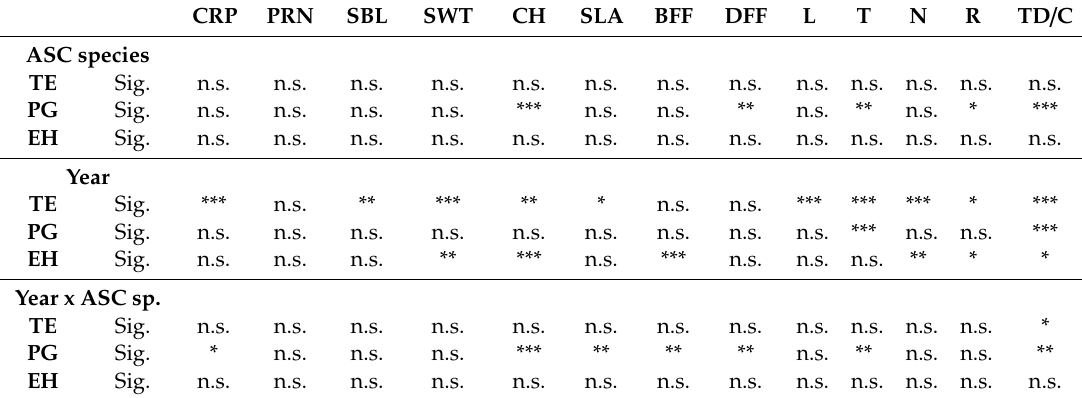
Table 3. Results of linear mixed model in the two-years experiment as a ff ected by the Year and the ASC species. CRP PRN SBL SWT CH SLA BFF DFF L T N R TD / C ASC species TE Sig. n.s. n.s. n.s. n.s. n.s. n.s. n.s. n.s. n.s. n.s. n.s. n.s. n.s. PG Sig. n.s. n.s. n.s. n.s. *** n.s. n.s. ** n.s. ** n.s. * *** EH Sig. n.s. n.s. n.s. n.s. n.s. n.s. n.s. n.s. n.s. n.s. n.s. n.s. n.s. Year TE Sig. *** n.s. ** *** ** * n.s. n.s. *** *** *** * *** PG Sig. n.s. n.s. n.s. n.s. n.s. n.s. n.s. n.s. n.s. *** n.s. n.s. *** EH Sig. n.s. n.s. n.s. ** *** n.s. *** n.s. n.s. n.s. ** * * Year x ASC sp. TE Sig. n.s. n.s. n.s. n.s. n.s. n.s. n.s. n.s. n.s. n.s. n.s. n.s. * PG Sig. * n.s. n.s. n.s. *** ** ** ** n.s. ** n.s. n.s. ** EH Sig. n.s. n.s. n.s. n.s. n.s. n.s. n.s. n.s. n.s. n.s. n.s. n.s.